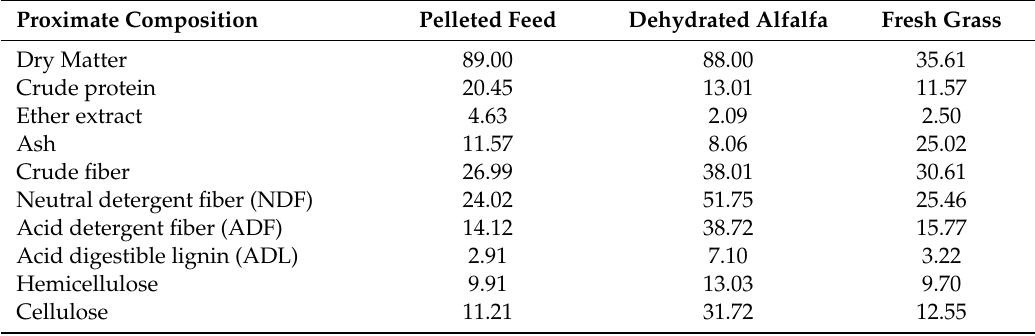
Table 1. Proximate composition of rabbit feed, dehydrated alfalfa, and fresh grass (g / 100 g of dry